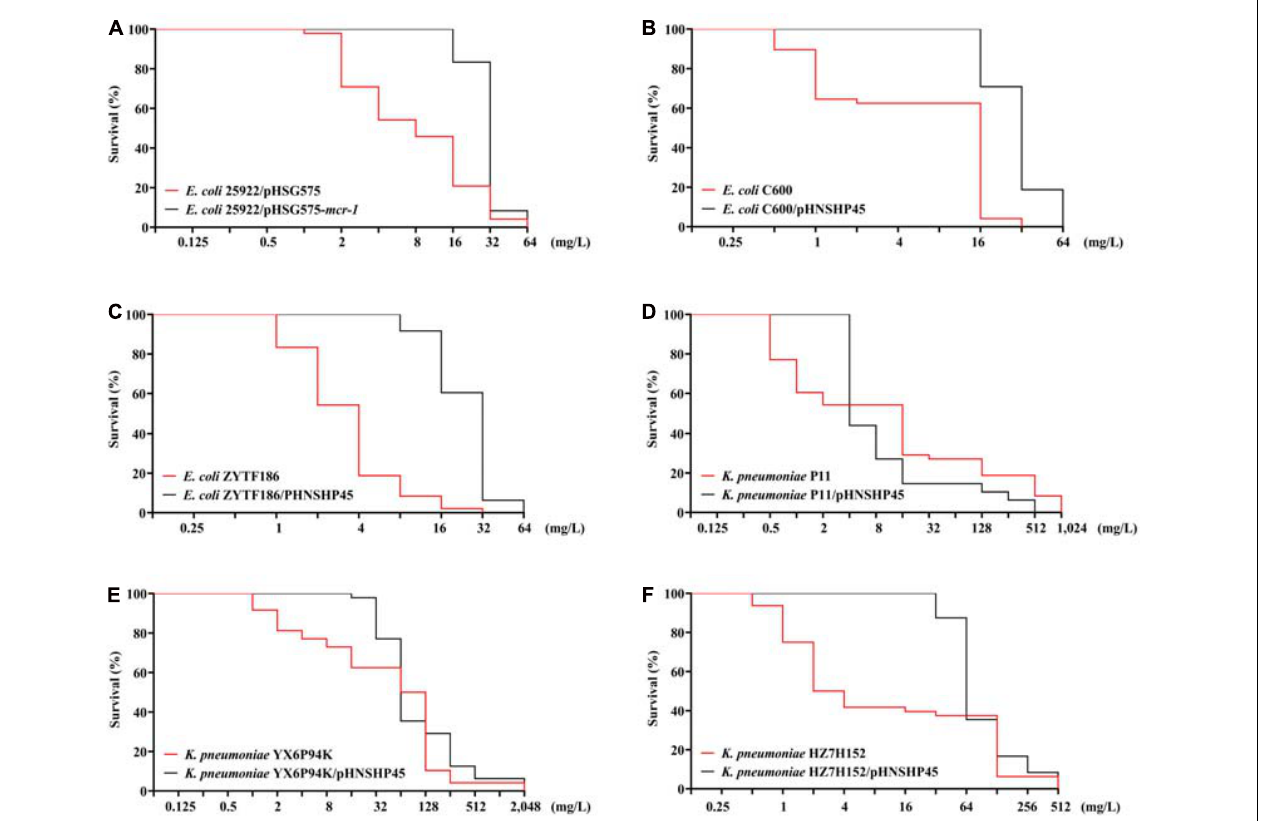
FIGURE 1 | Survival curves of E. coli (A–C) and K. pneumoniae strains (D–F) and their mcr-1 -positive transformants in the presence of increasing concentrations of